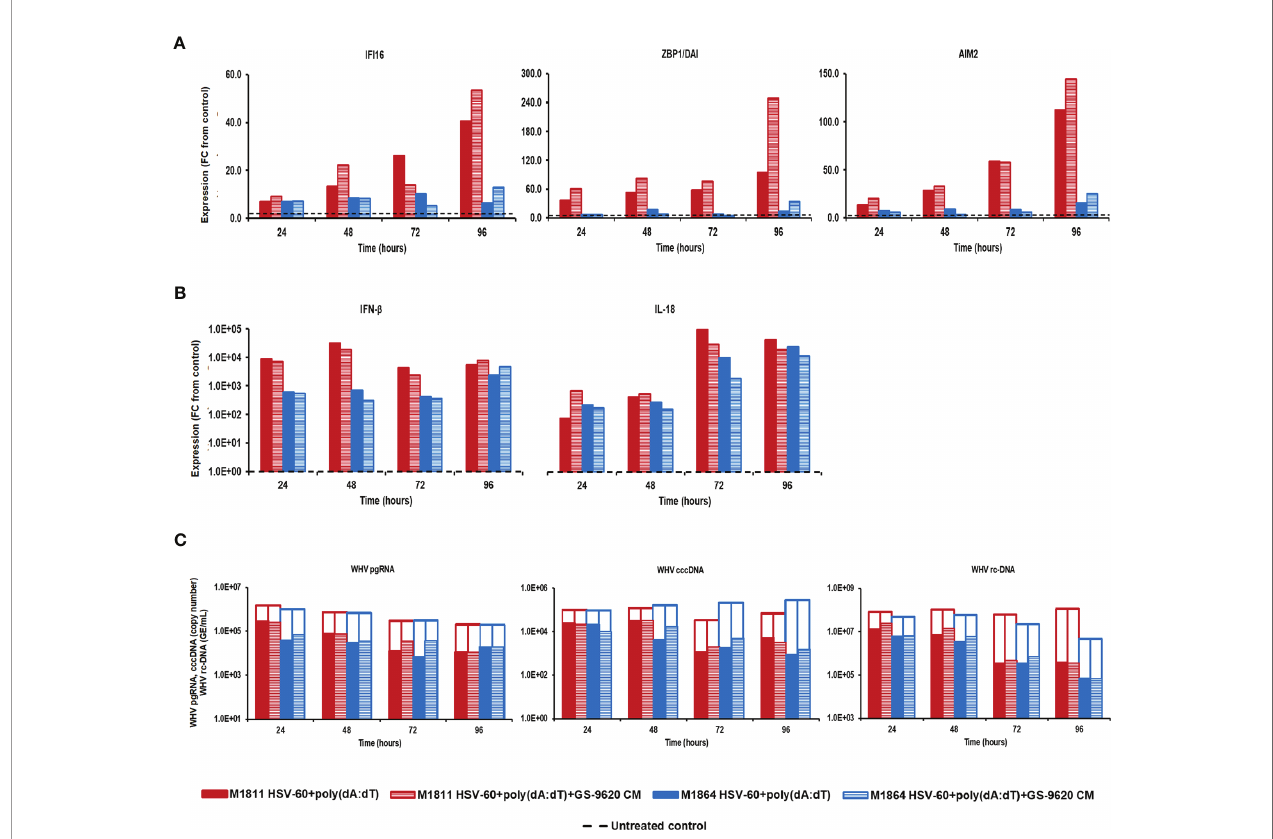
FIGURE 4 | Parallel agonistic activation of IFI16, ZBP1/DAI, and AIM2 receptor pathways together with exogenously added type-I IFNs fails to enhance WHV suppression. PBMCs and PWHs were generated from two woodchucks with CHB, GS-9620 CM was obtained from GS-9620 treated PBMCs, and used to treat PWHs from each animal at T0 and again at 48 hours together with HSV-60 and poly(dA:dT). The fold-changes in transcript level of (A) IFI16, ZBP1/DAI, and AIM2 and (B) IFN- b and IL18 over 96 hours are shown for treatment with the double (HSV-60 + poly(dA:dT)) or triple combination (HSV-60 + poly(dA:dT) + GS-9620 CM), when compared to their transcript level in untreated control PWHs from individual animals at each timepoint, which that was set at 1.0 and is indicated by the dotted line. (C) The changes in WHV replication (pgRNA and cccDNA) and secretion (rc-DNA) during double and triple combination treatment are presented for untreated control (empty bars) and agonist/GS-9620-treated PWHs (colored bars) from individual animals at each timepoints. FC,